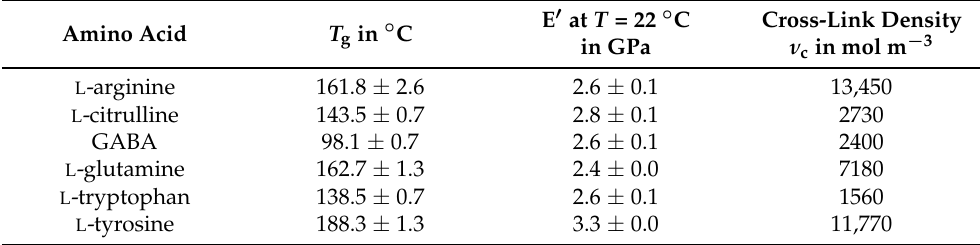
Table 2. Glass transition temperature T g , storage modulus E (cid:48) , and cross-link density ν c of amino- epoxides (average ± standard